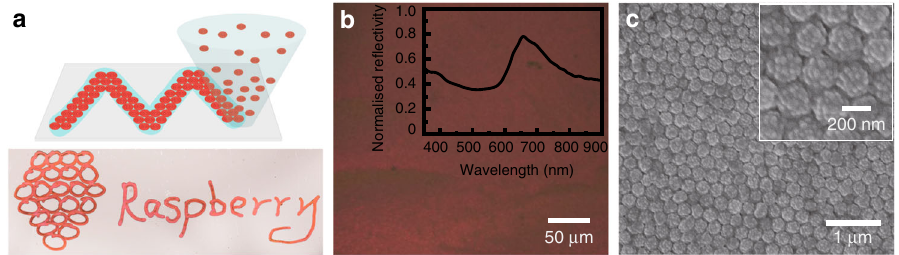
Fig. 6 Re fl ectivity properties of raspberry-particle ink. a Cartoon illustrating how raspberry colloidal dispersions (3 w%) can be used as ink on a coverslip and a corresponding sample photographed in re fl ection at a speci fi c angle. b Microscopic image taken in re fl ective mode of a dried fi lm made of raspberries and the corresponding re fl ectivity curve (inset). c SEM image of self-assembled raspberry particles on a glass